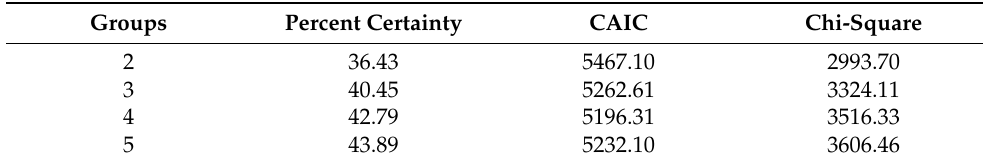
Table 2. Summary from latent class analysis highlighting best replications. Groups Percent Certainty CAIC